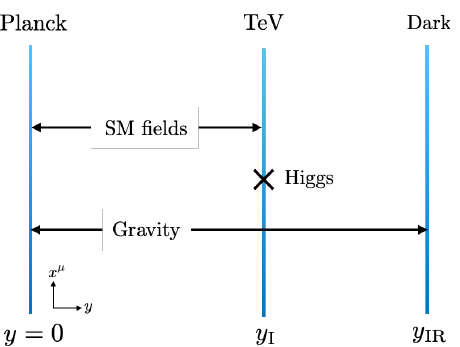
Figure 7 . The three 3-brane model to introduce a dark sector. The typical mass scales of the UV, intermediate and IR branes are identified as the Planck, TeV and some smaller dark sector mass scales. Here, we call the IR brane as the dark brane. The SM fields live in the bulk subregion between the Planck and TeV branes, while the SM Higgs field is localized at the TeV brane. Gravity propagates in the whole bulk